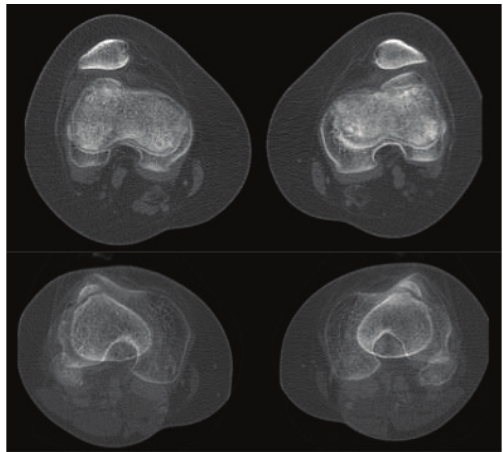
Figure 1: Top: CT-scan of both knees performed at the age of 15 years, showing bilateral patellofemoral dysplasia and permanent subluxation of patella. Bottom: distance TT-TG (tibial tubercle- trochlear groove) of 19 and 27mm at the left and right side, respectively.